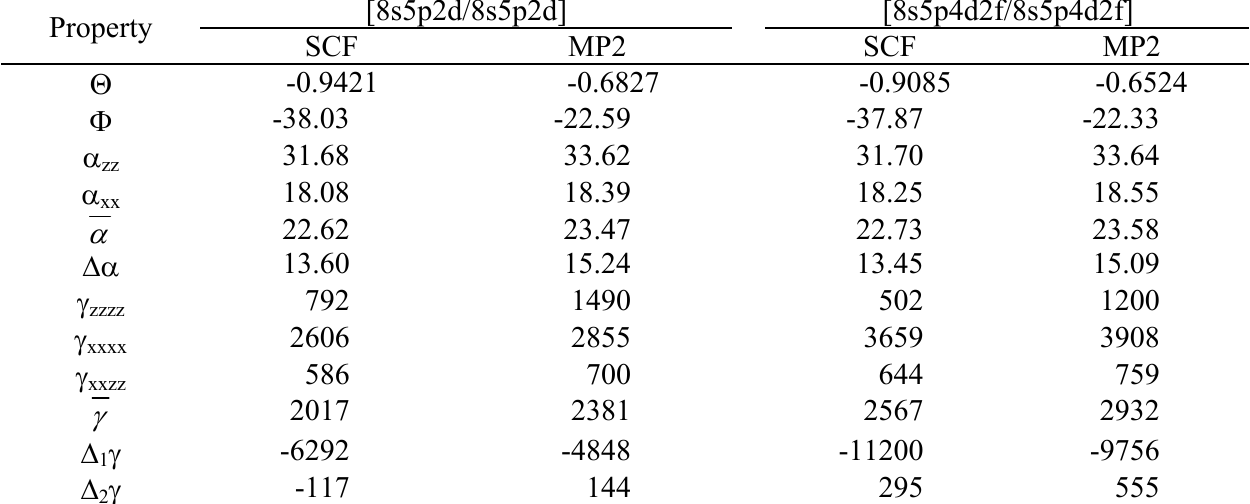
Table 1. Electric properties of FCCF a .